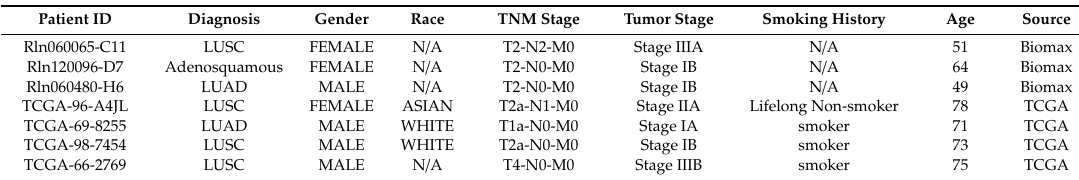
Table 6. Clinical information of the EBV( + ) NSCLC